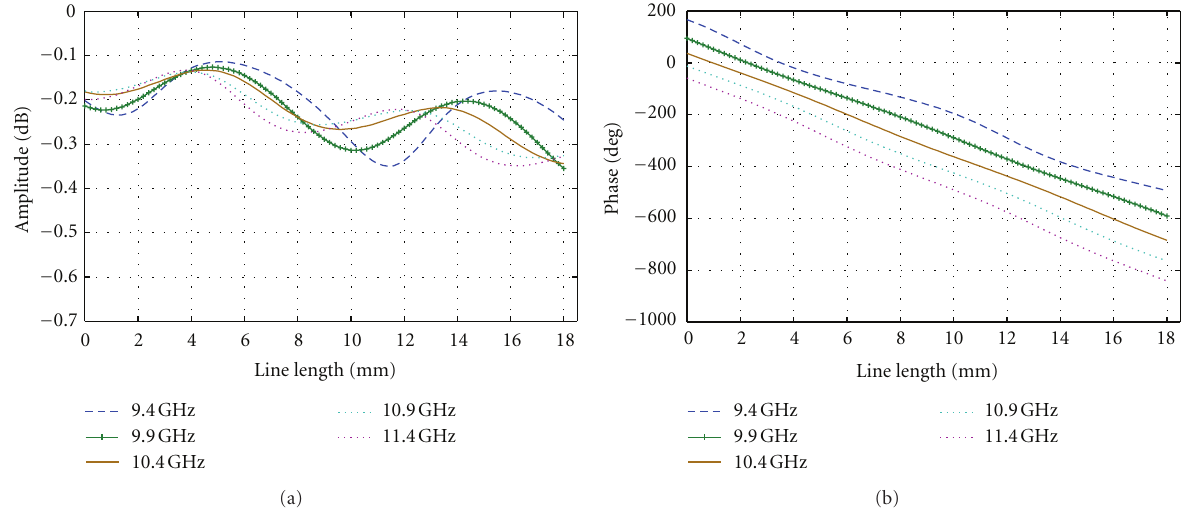
Figure 12: Reflection coe ffi cient in free space versus the line length for the reflectarray element with two stacked patches. (a) Amplitude. (b)